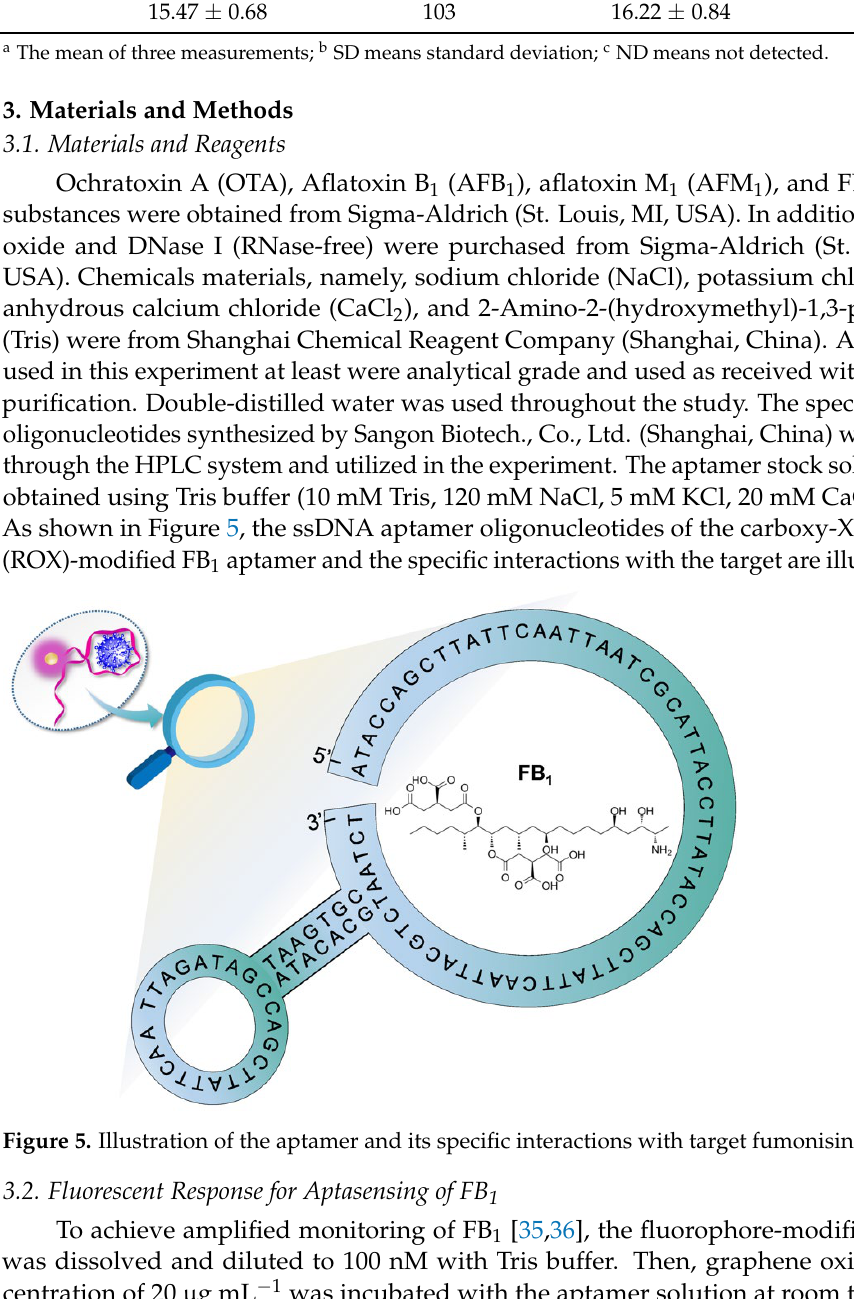
Table 2. Detection of FB 1 in the wheat flour samples.